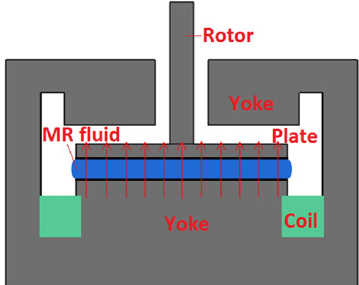
Figure 2. Configuration of the test system of the compressive properties of MR fluids under